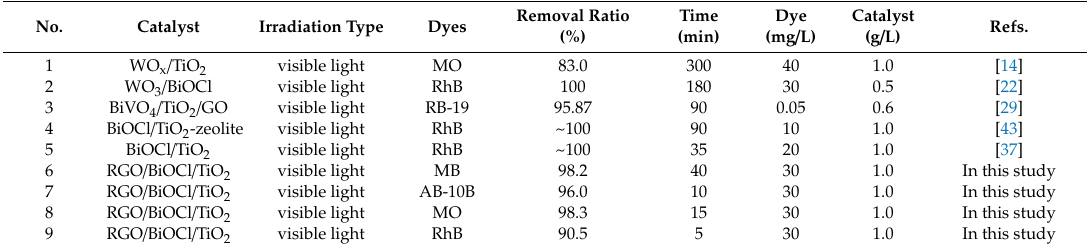
Table 2. Comparison of catalytic activity of RGO / BiOCl / TiO 2 nanocomposites with some reported catalysts in the degradation of organic